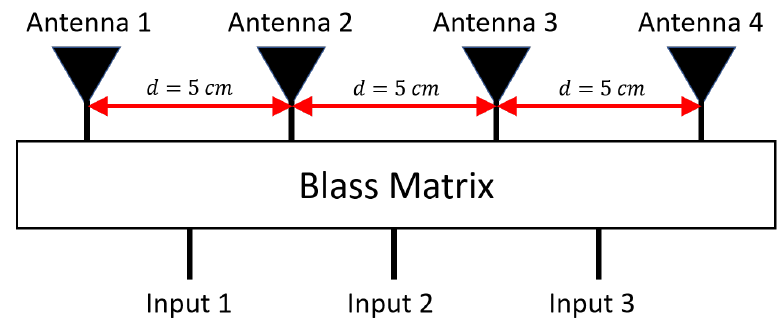
Figure 18. Example of array fed by the Blass matrix